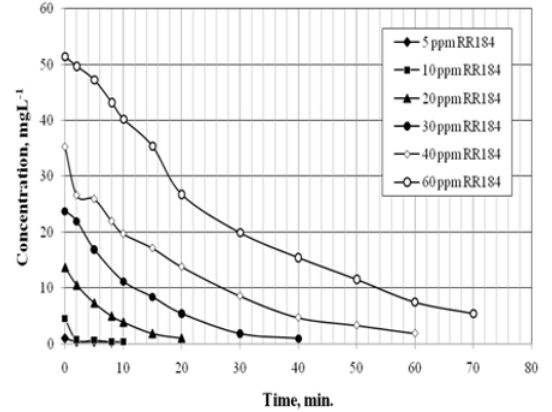
Figure 4. The influence of initial concentration of RR184 on the photodegradation process.